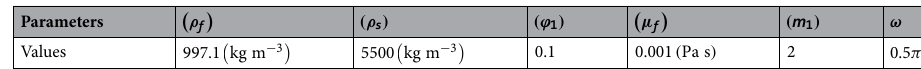
Table 1. Numeric values of nano-particle properties utilized in the present study 4,16 .